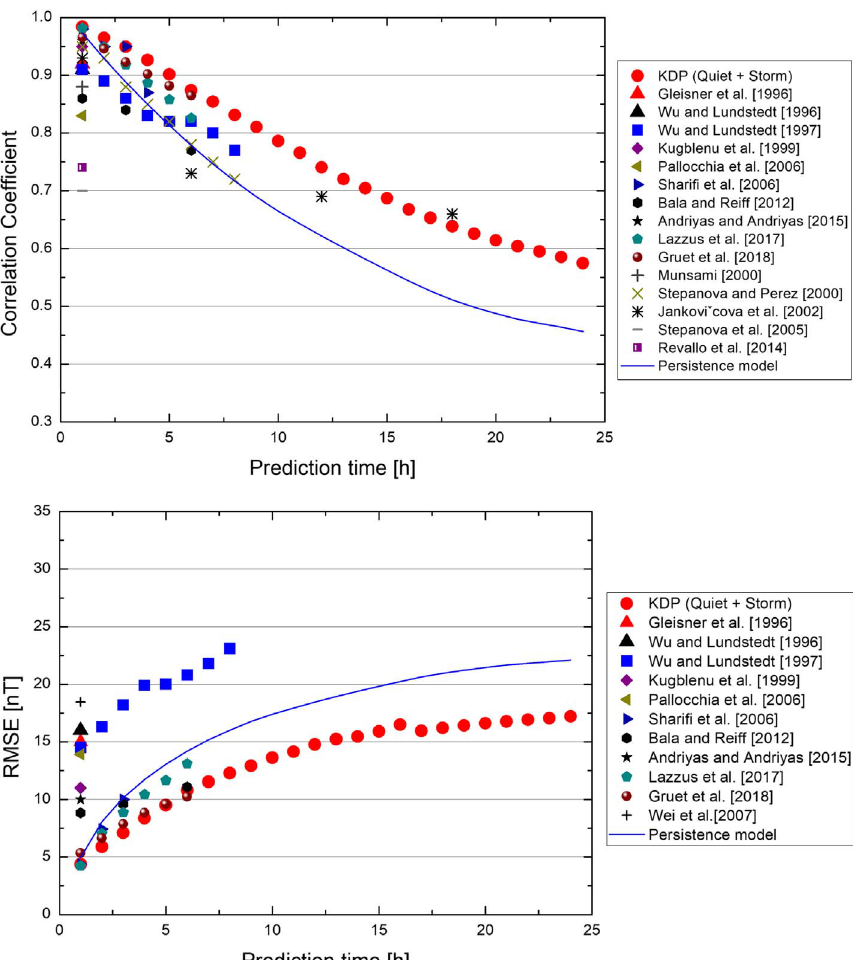
Fig. 9. Comparison of KDP model performance with other models: correlation coef fi cient (up) and RMSE (down). The red circles show prediction results from the KDP model for both quiet and storm time, and the red triangles indicate the model performance for only storm